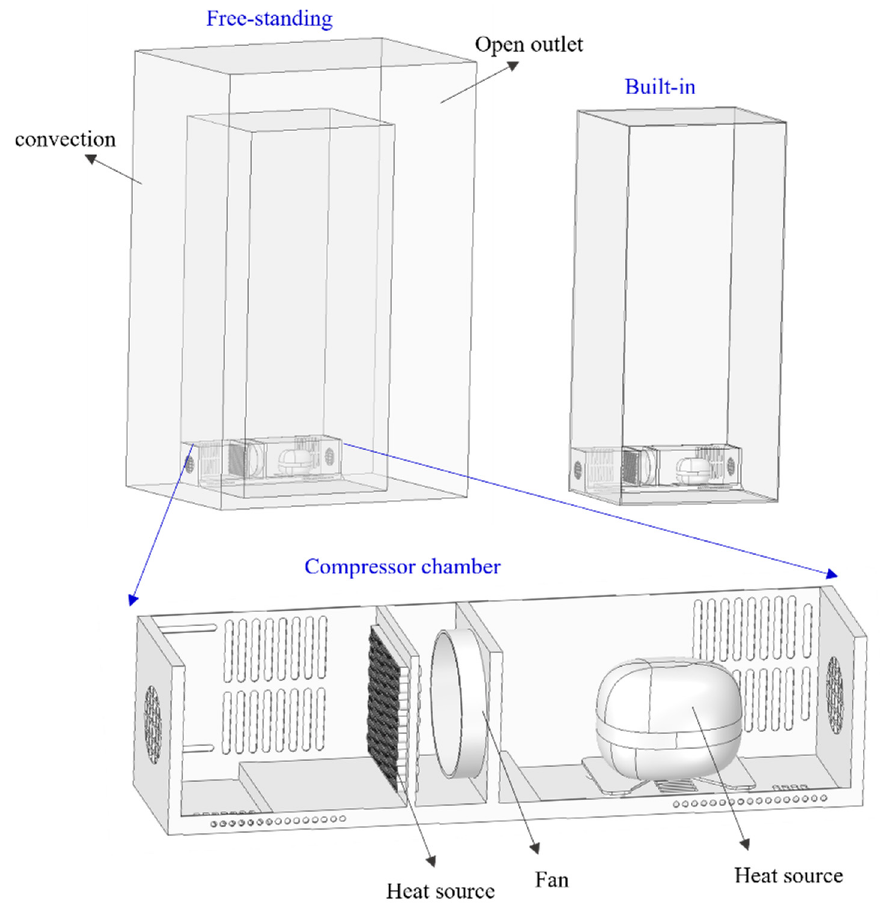
Figure 3. CFD model of the refrigerator under two installation conditions.